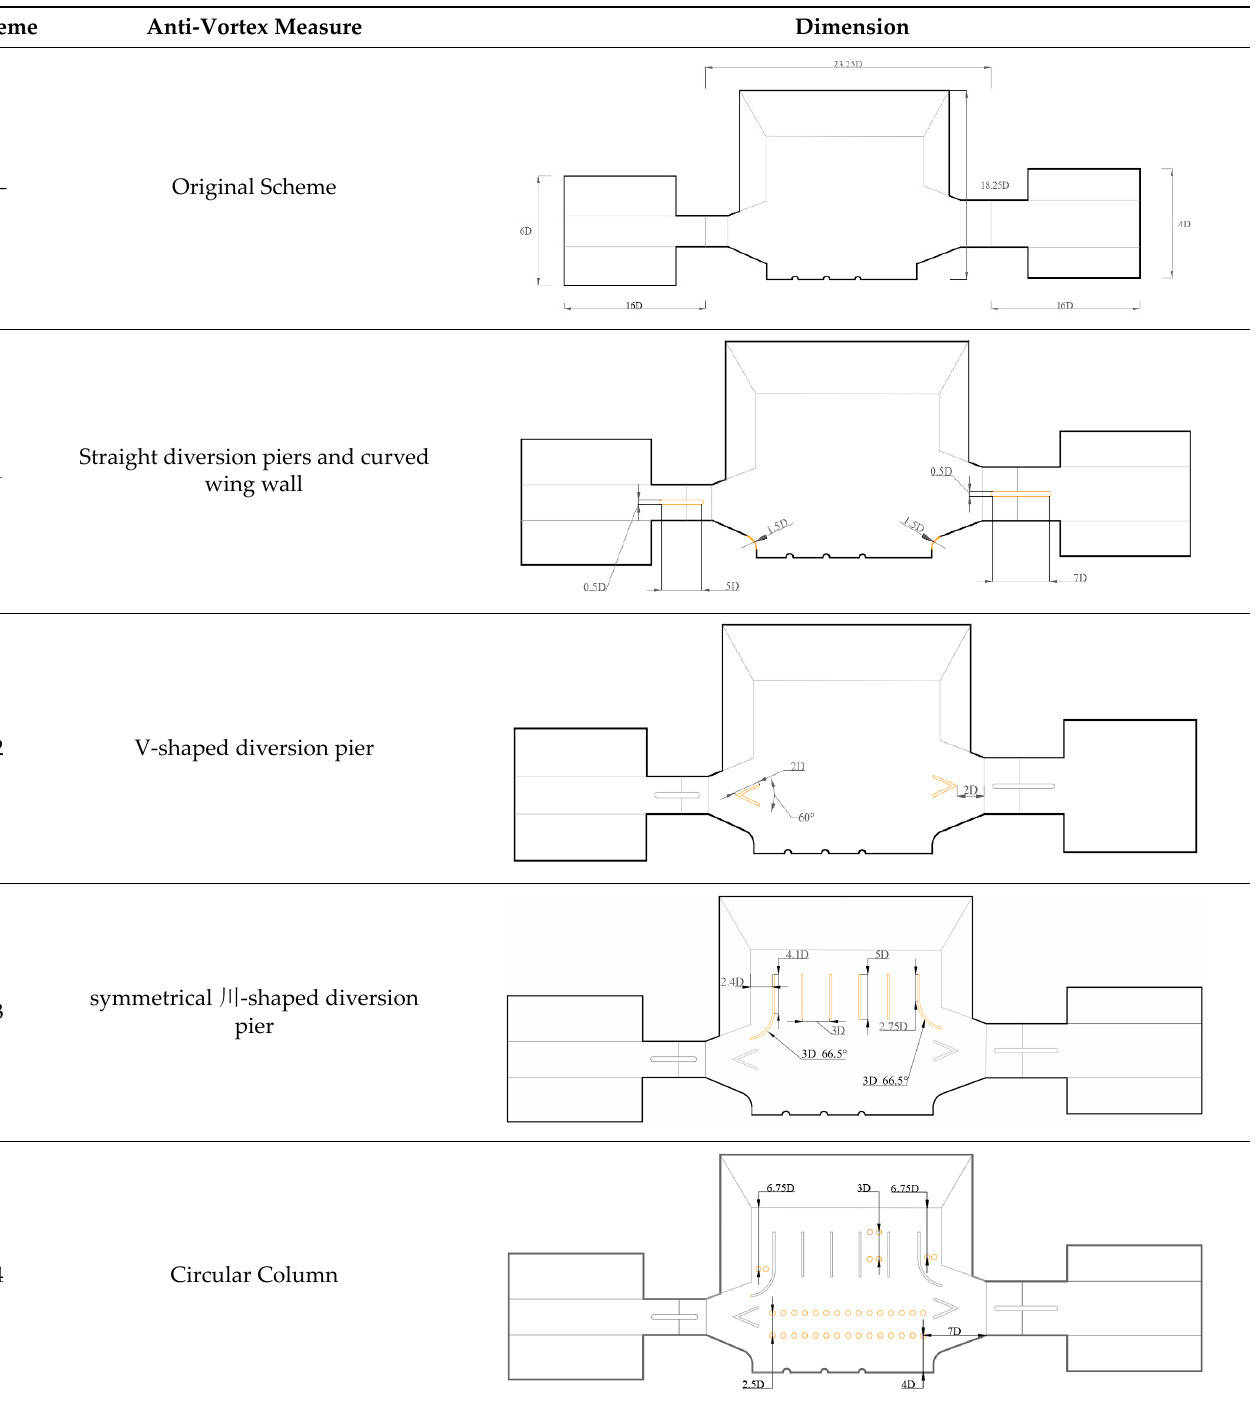
Table 1. Anti‑vortex measures in the